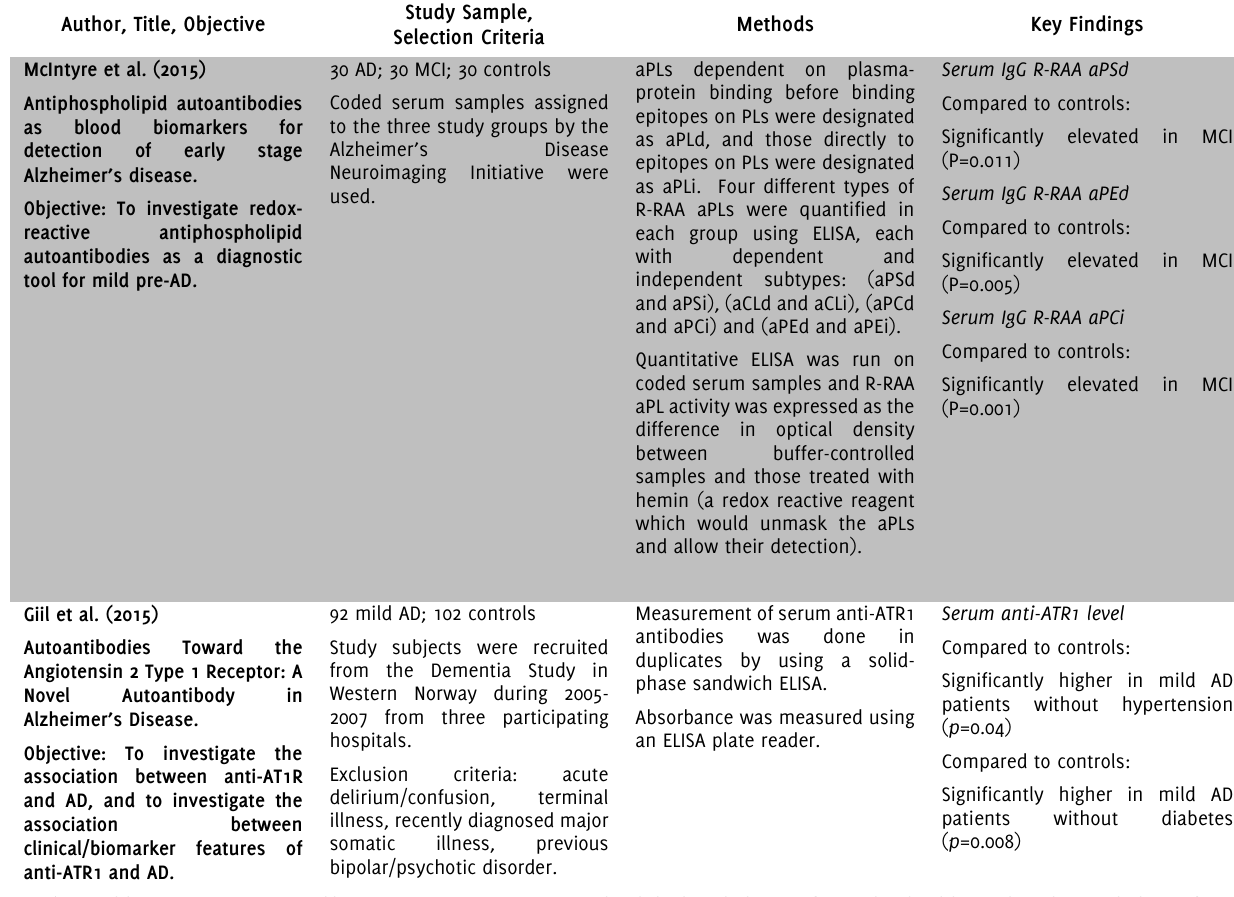
Table 2 . Autoantibodies as biomarkers for Alzheimer’s